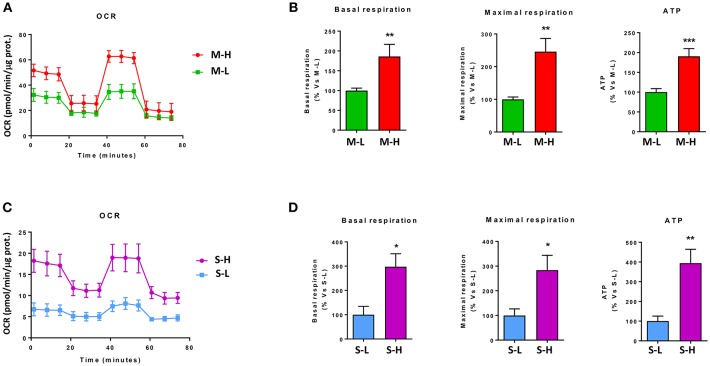
e-CSCs have increased oxidative mitochondrial metabolism. The oxygen consumption rate (OCR) was measured, using the Seahorse XFe96 metabolic-flux analyzer. Note that high OCR in MCF7 cells directly correlates with high-flavin content. For example, M-H cells (from 2D-monolayers) and S-H cells (from 3D-spheroids) have the highest levels of OCR, as compared to the M-L and S-L sub-populations. (A,B) OCR for M-L vs. M-H sub-populations; (C,D) OCR for S-L vs. S-H sub-populations. *p < 0.01, **p < 0.001 and ***p < 0.0001.